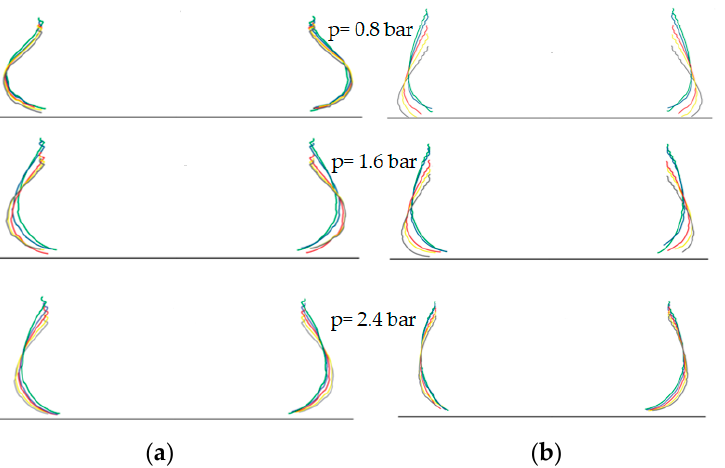
Figure 4. Visualization of vertical cross-sections at different levels of vertical load and inflation pressures: radial tire ( a ); bias—ply tire ( b ), p—inflation pressure; gray—2400 kg, yellow—2000 kg, red—1600 kg, blue—1200 kg, 800 kg—green.